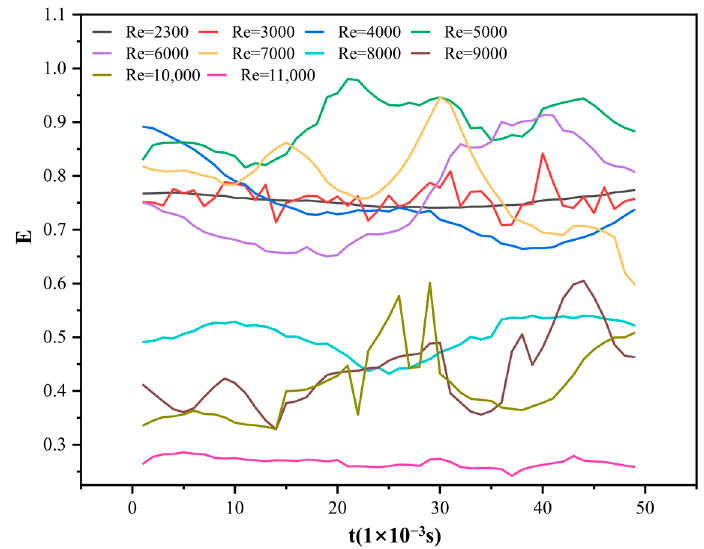
Figure 18. The changing law of bubble aspect ratio.